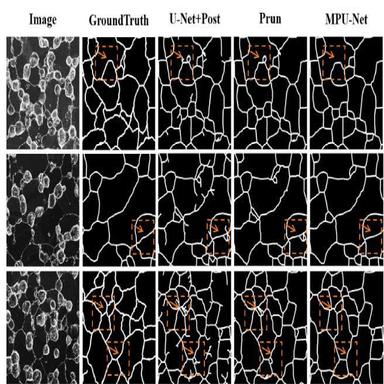
Qualitative results of different methods on the FESEM Dataset.